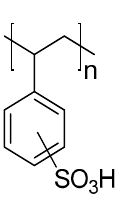
Figure 2. Structure representation of the acidic cation-exchange resin derived from the ST-DVB co- polymer.